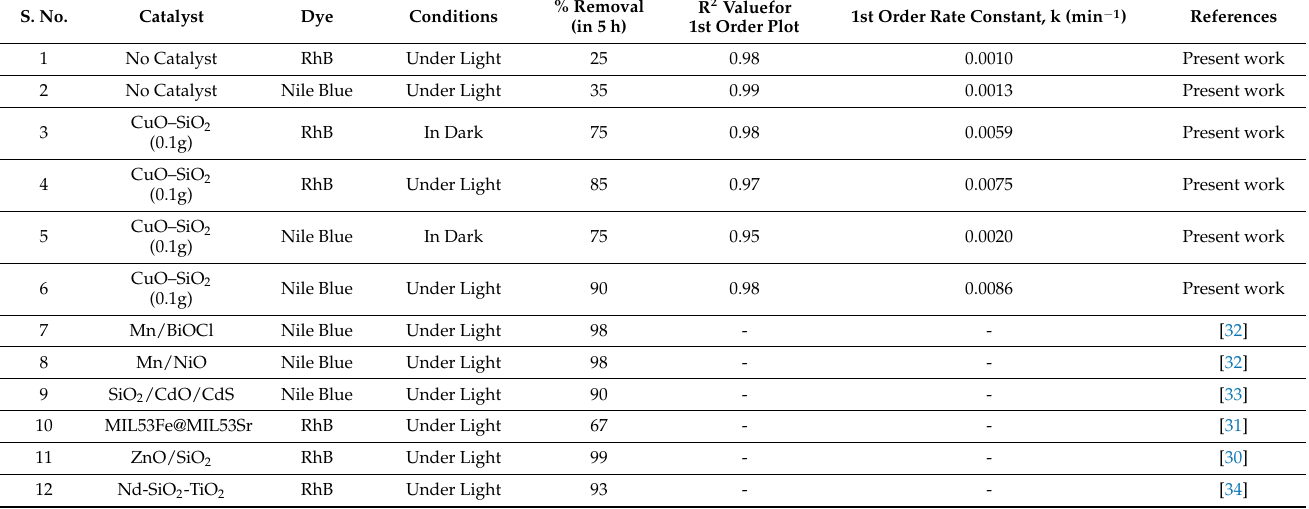
Figure 7. Degradation summary of RhB in the presence of 0.1g CuO–SiO 2 particles in the dark. ( a ) variation in UV-Visible spectra/absorbance at different intervals of time, ( b ) ratio of absorbance (At/A 0 ) versus time, ( c ) percentage of decomposition versus time, and ( d ) characteristic plot of pseudo-first-order kinetics of degradation. Table 1. First-order rate constants, regression values, and percentage removal efficiencies of CuO– SiO 2 and some selected composites toward the catalytic/photocatalytic degradation of rhodamine B (RhB) and Nile Blue (NB).